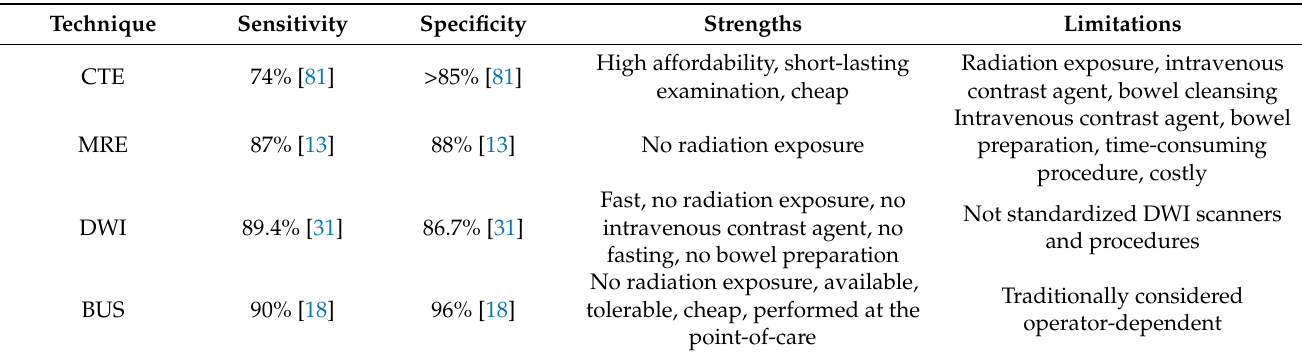
Table 2. Accuracy, advantages and disadvantages of the different imaging techniques for assessment of activity in